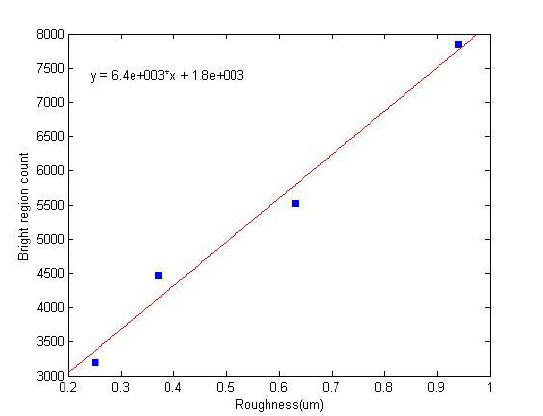
Fig. 6: The number of bright regions counts as a function of roughness. 3) Size of speckle spot method. The variation of the spot size with